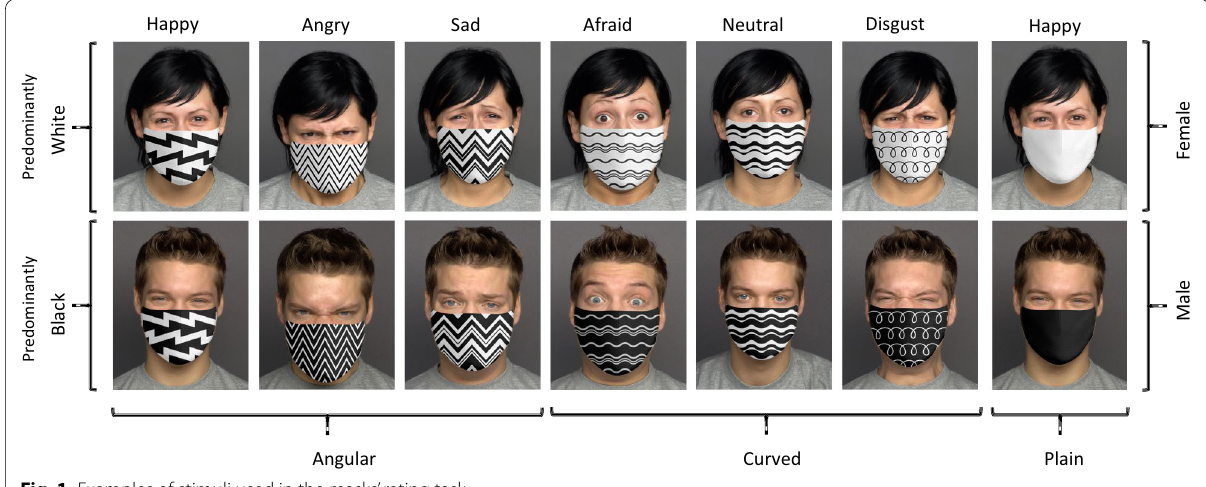
Fig. 1 Examples of stimuli used in the masks’ rating